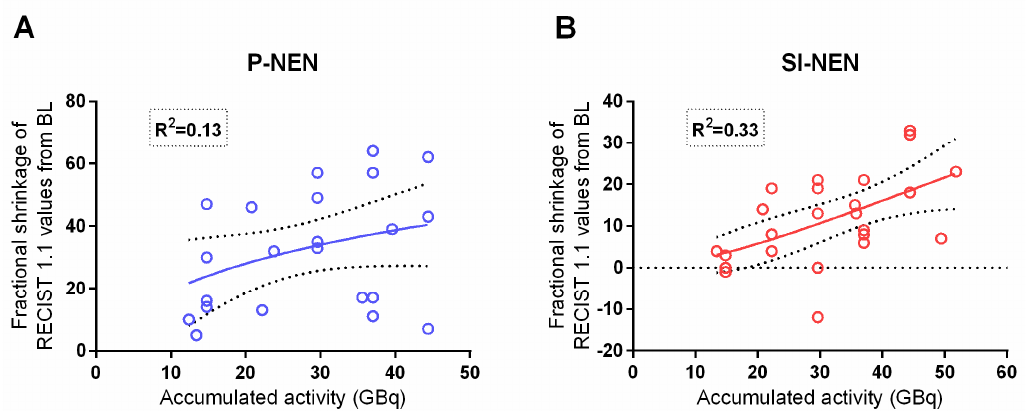
Figure 2. Correlation between accumulated activity (GBq) and RECIST 1.1 values. Accumulated activity (GBq) versus RECIST 1.1 values. ( A ) P-NENs ( n = 23) and ( B ) SI-NENs ( n = 25). P-NENs ( p = 0.1) ( B ) SI-NENs ( p < 0.01). Two patients in each group have identical values. BL; baseline.